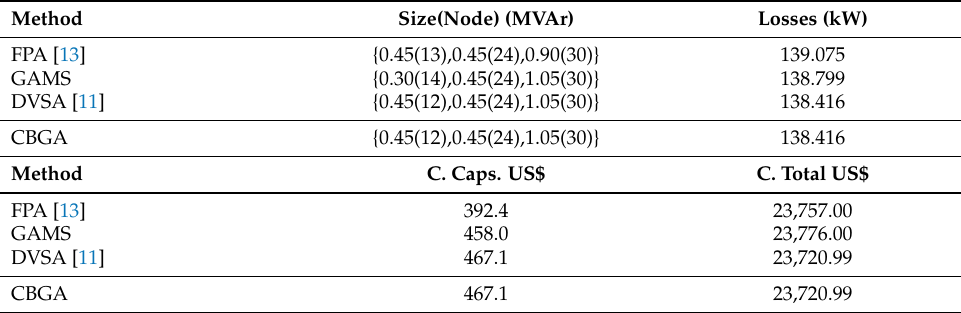
Table 9. Location of capacitors in the 33-node test